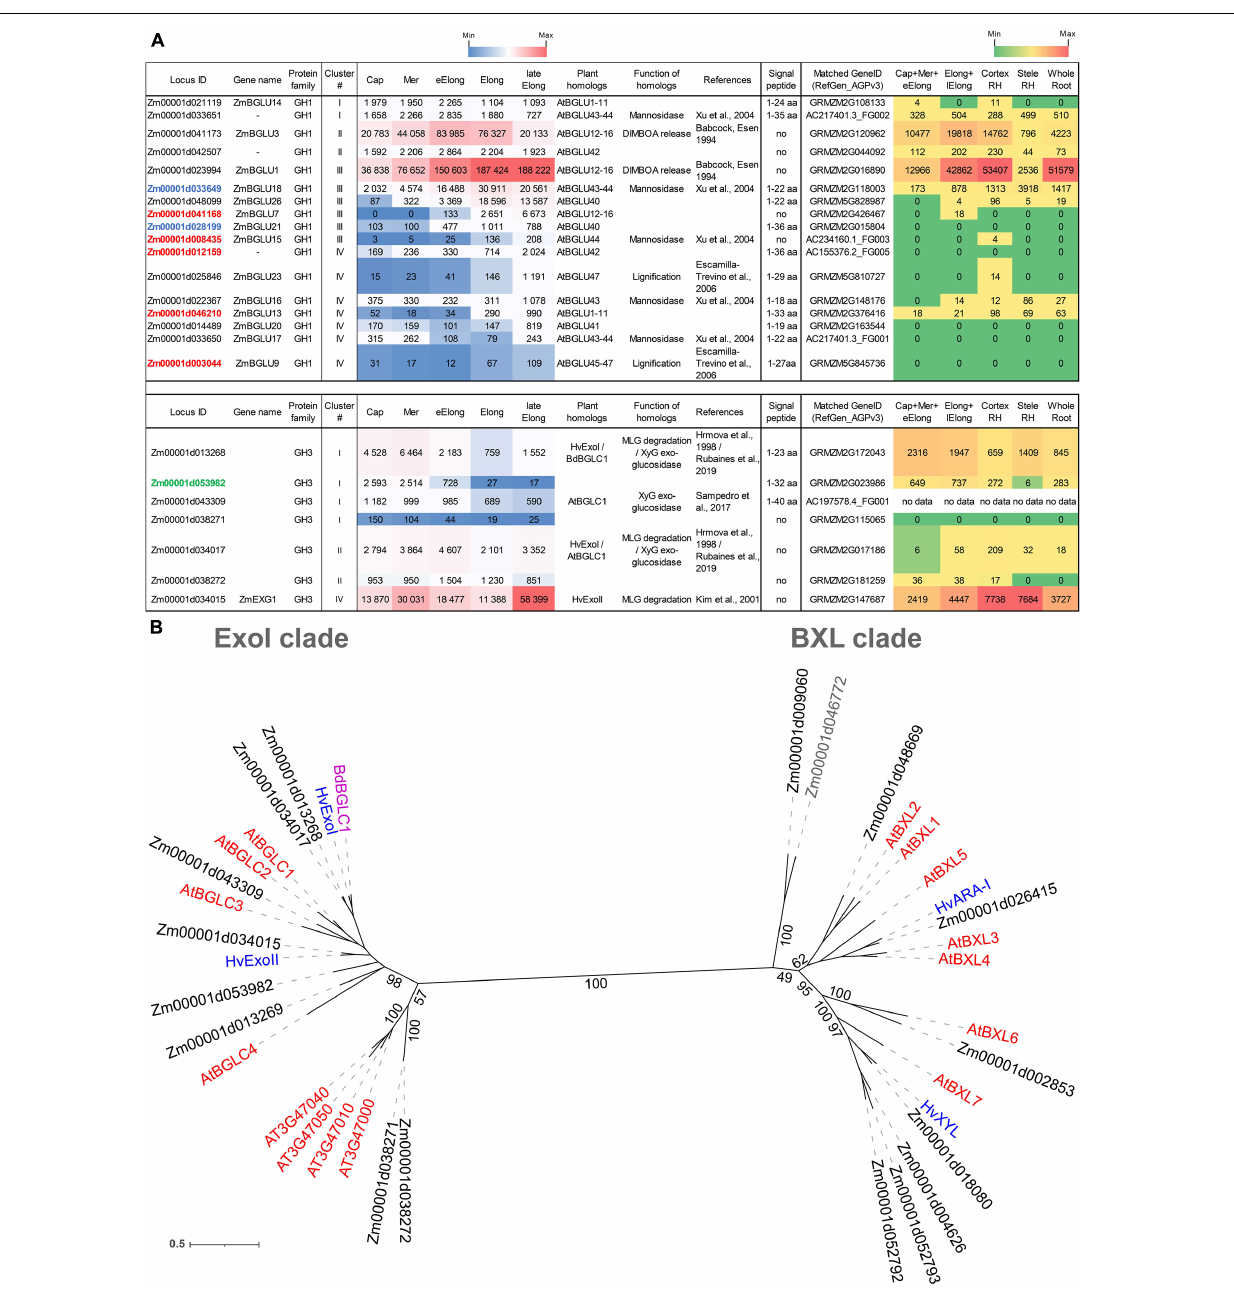
FIGURE 3 | Expression of maize genes encoding putative GH1 and GH3 β - D -glucosidases in maize roots and phylogenetic analysis of plant GH3 family members. (A) The level of transcripts (TGR, red-blue heat map) and abundance of corresponding protein (averaged and normalized total spectral counts (Marcon et al., 2015, red-green heat map) of genes encoding putative β - D -glucosidases of GH1 and GH3 protein families in analyzed zones of maize roots. Heat map color-coding was applied to each protein family separately. Genes with expression values below 100 in all the studied samples are not shown. TGR values are sorted from maximum to minimum within each cluster. Maize genes that co-expressed with primary and secondary cell wall cellulose-synthases, and with the XyG backbone synthase are given in blue, red, and green, respectively. Maize GH1 gene names are given according to Gómez-Anduro et al. (2011). ZmEXG1 is named after Kim et al. (2000). Cap, root cap; Mer, meristem; eElong, early elongation zone; Elong, zone of active elongation; lateElong, zone of late elongation before root hair initiation; RH, root hair zone; aa, amino acids; no data, no corresponding peptides were found by Marcon et al. (2015) proteomic analysis. (B) The unrooted maximum likelihood phylogenetic tree of plant GH3 members. Maize expressed genes are given in black, and unexpressed (TGR values lower than 16 in all the analyzed root samples) in gray, Arabidopsis thaliana genes in red, and barley in blue (only genes encoding enzymes with characterized enzymatic activity are shown (Hrmova et al., 1996; Hrmova and Fincher, 1997; Lee et al., 2003), Brachypodium distachyon BdBGLC1 ( Bd1g08550 ) (Rubianes et al., 2019) is given in purple. The A. thaliana gene names follow Minic et al. (2004) for the BXL clade and follow Sampedro et al. (2017) for the ExoI clade. Numbers indicate ultrafast bootstrap support values for some